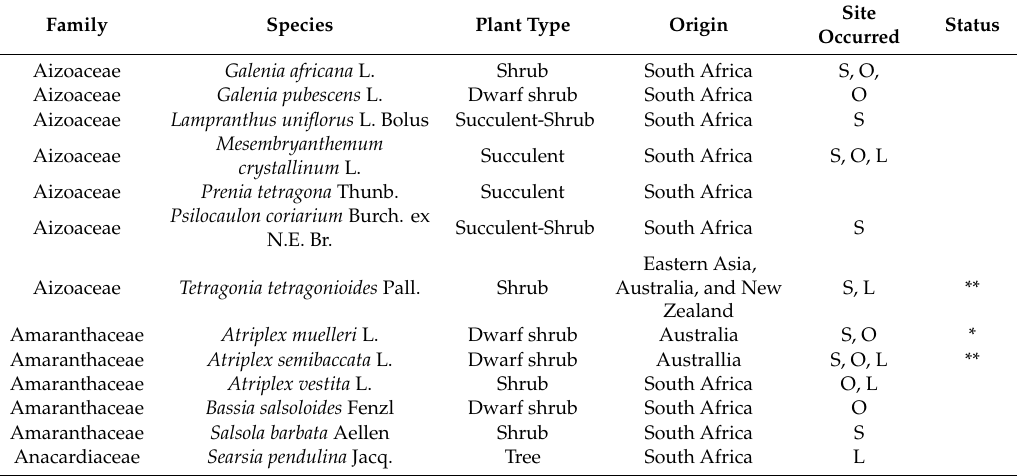
Table 1. Plants sampled along the Swart (S), Olifants (O), and Leeu (L) rivers in Western Cape, South Africa, where exotic Tamarix invasion was most prevalent. Alien plants have been marked with an * while listed invasive species have been marked with